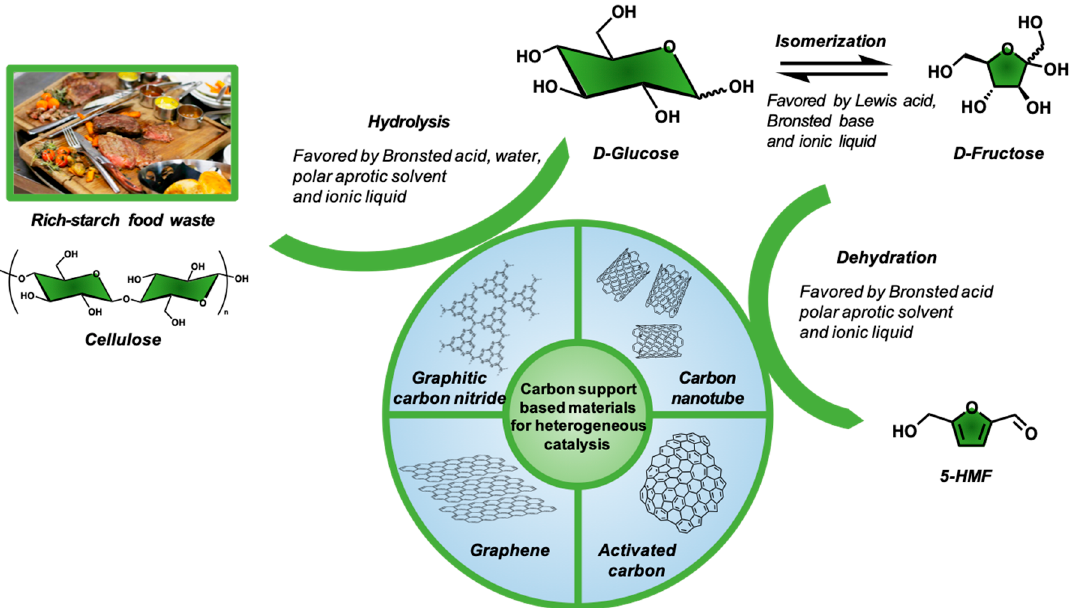
Figure 1. Chemical pathways for 5-HMF production from rich-starch food waste and cellulose using carbon support-based materials.